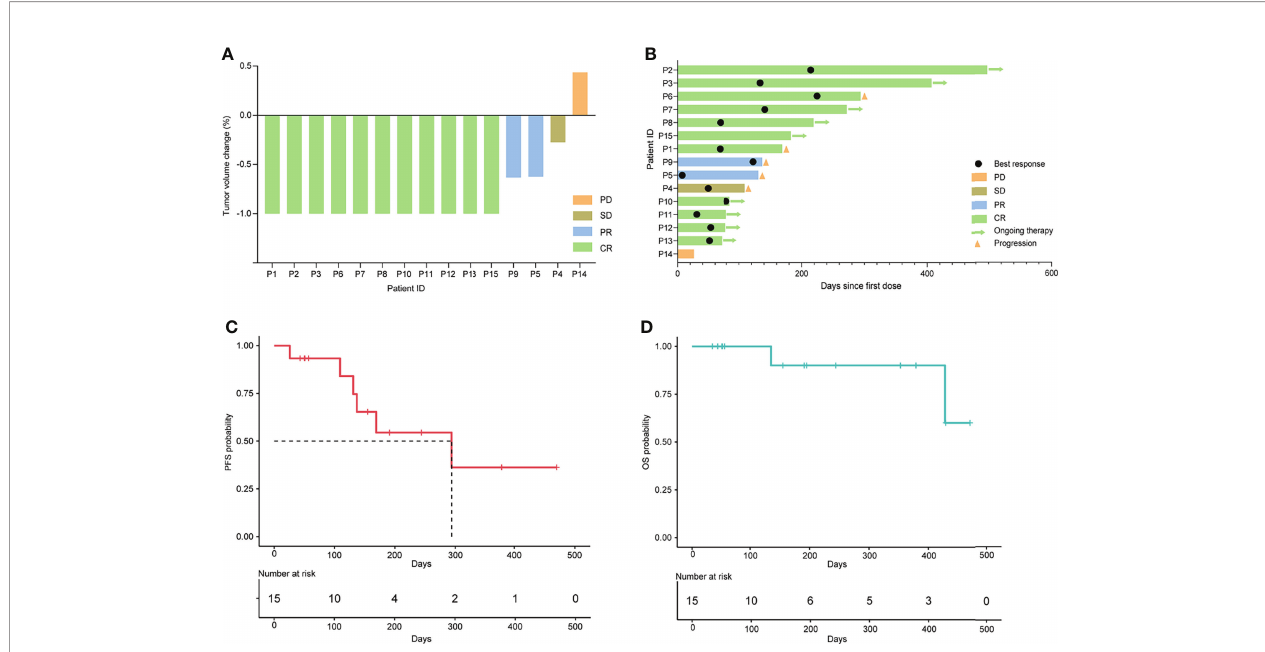
FIGURE 1 | Clinical response to orelabrutinib-containing combination therapy in r/r PCNSL. (A) Tumor volume change between best response and baseline. (B) Best response and the duration of the combination therapy. (C) Kaplan-Meier analysis for progression-free survival. (D) Kaplan-Meier analysis for overall survival.